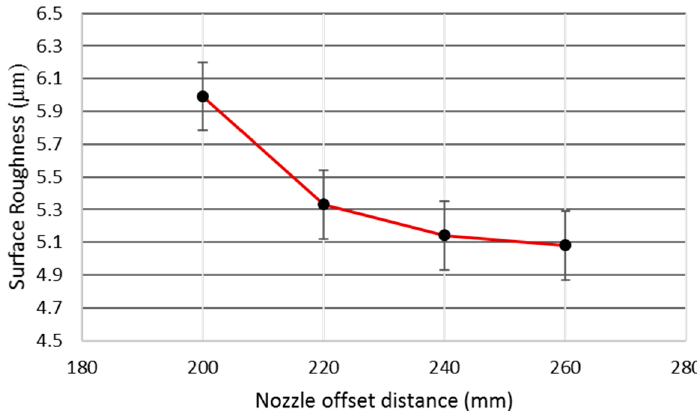
Figure 9. E ff ect of N OD on surface roughness. Figure 9. Effect of N OD on surface roughness. Figure 9. Effect of N OD on surface roughness.